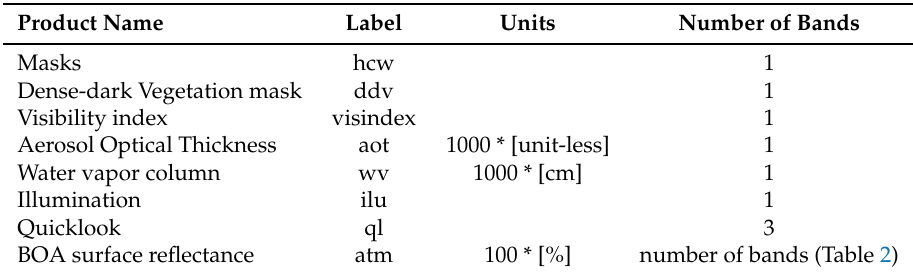
Table 1. Intermediate and final products resulting from PACO software execution.